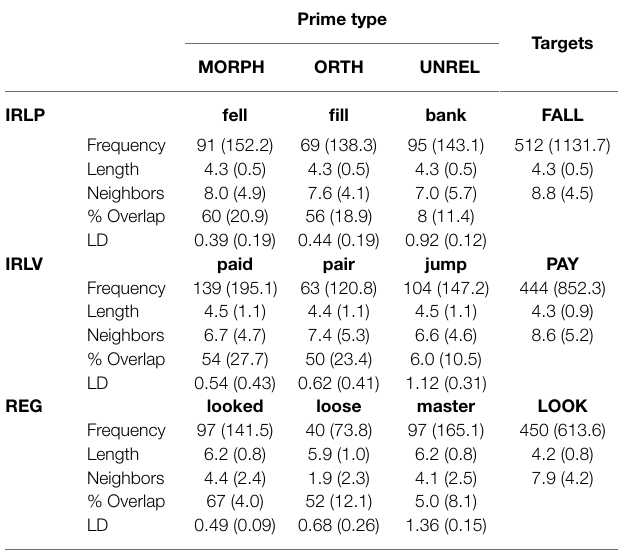
TABLE 1 | Lexical characteristics and examples of prime-word target pairs used in Experiment